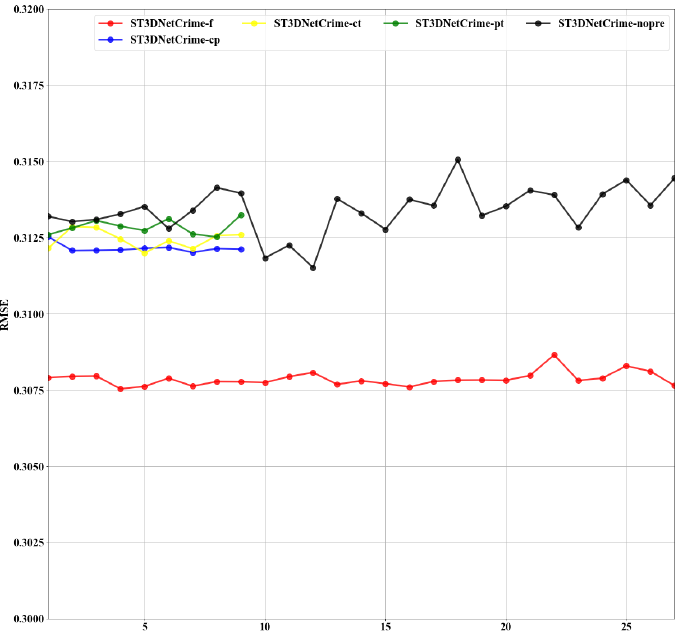
Figure 9. The evaluation results of variants of ST3DNetCrime.Units: x -axis: number of combinations of the independent sequence lengths; y -axis: RMSE